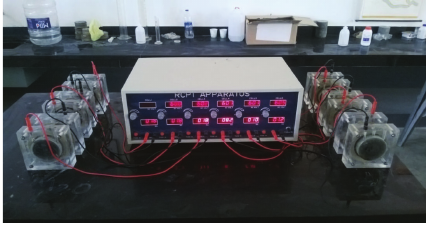
Figure 4: RCPT test.